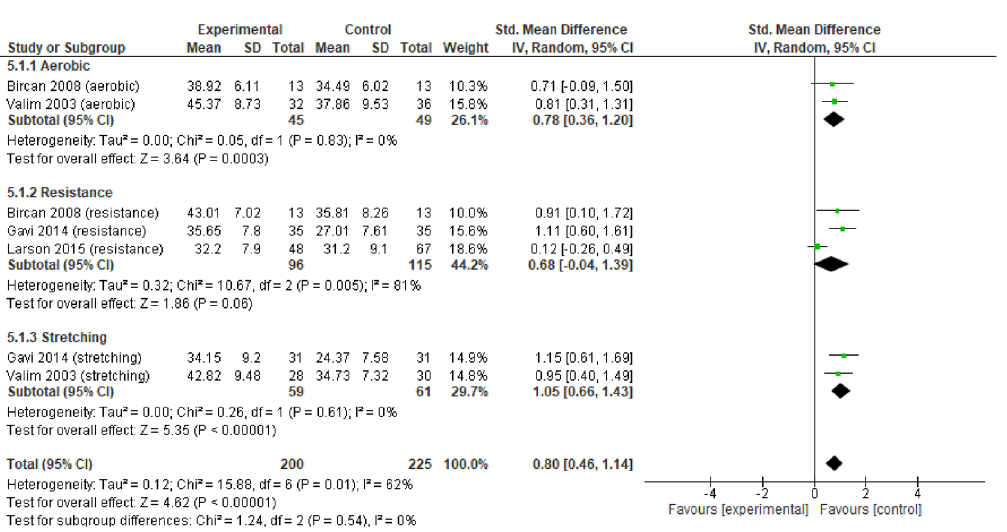
Figure 8. Forest plots showing the effect of training on the Physical Component of HRQOL